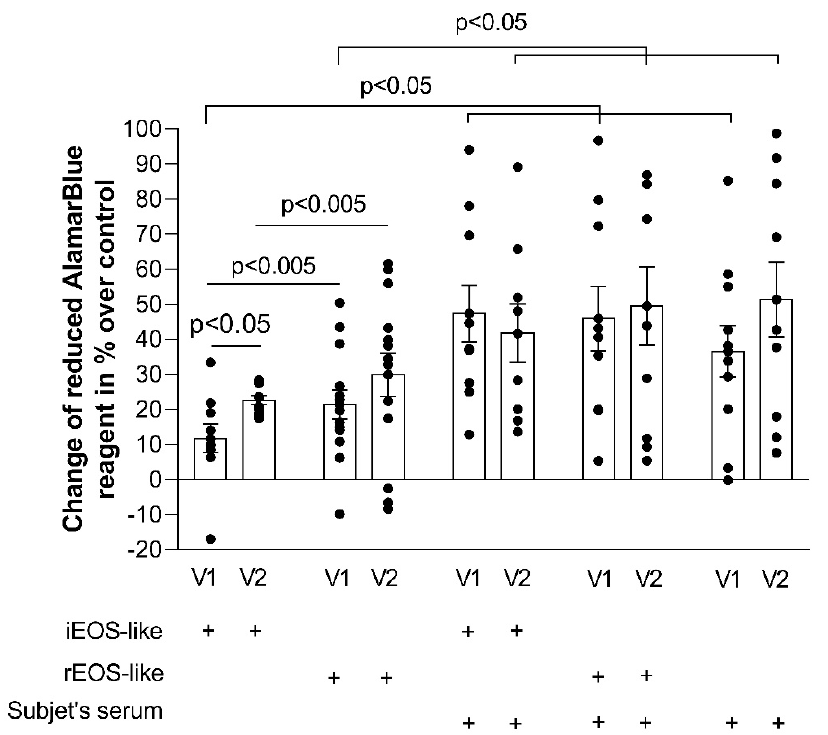
Figure 6. Effect of the bronchial allergen challenge on rEOS-like and iEOS-like cells promoted ASM cell proliferation. AA, allergic asthma; V1, visit 1 (before the bronchial allergen challenge); V2, visit 2 (24 h after the bronchial allergen challenge). Results from independent experiments of AA, n = 13. Statistical analysis: between investigated groups, Mann–Whitney two-sided U-test; within one study group, comparing each point of the subject individually, Wilcoxon matched-pair, signed-rank, two-sided test.